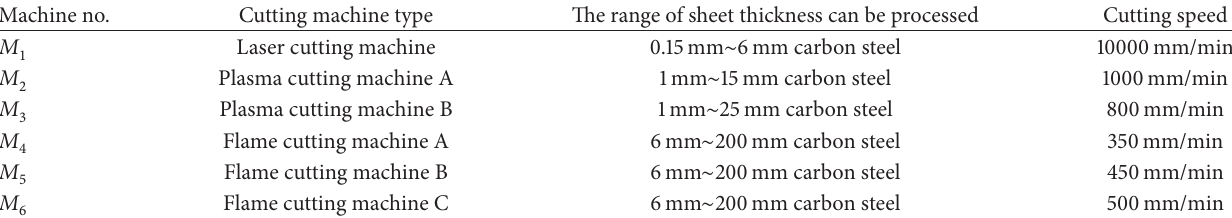
Figure 1: The production process of sheet cutting. Table 1: The capacity of different cutting